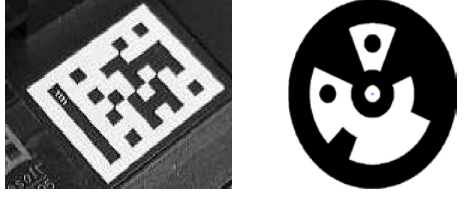
Figure 3. ARToolkit and InterSence.